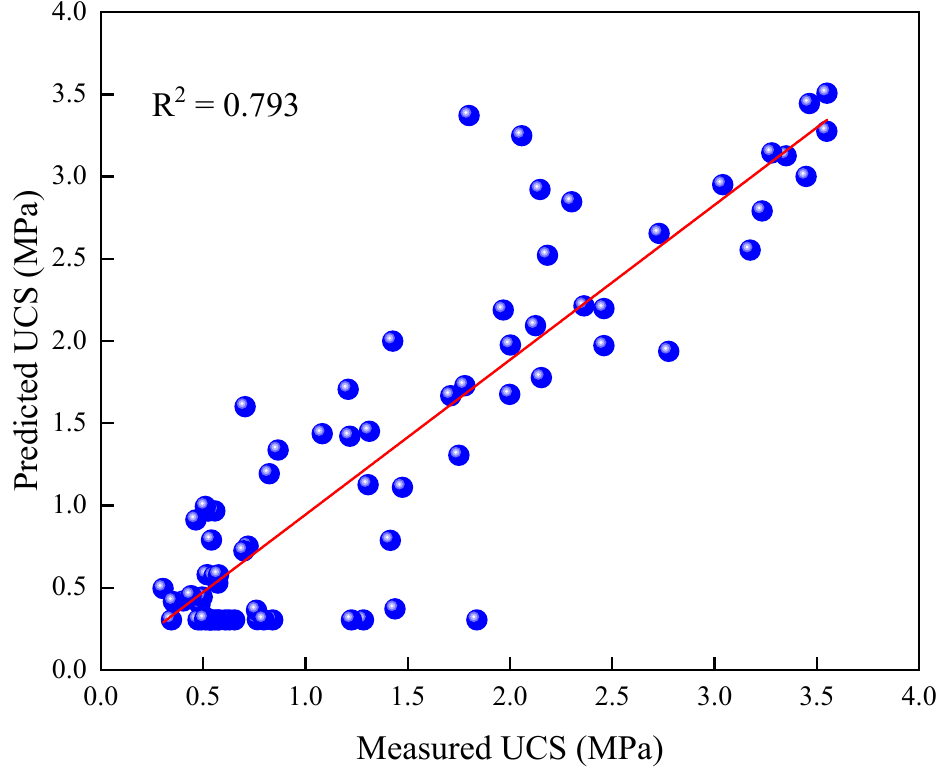
Figure 9. ANN model M1 results for UCS plotted against the measured data.